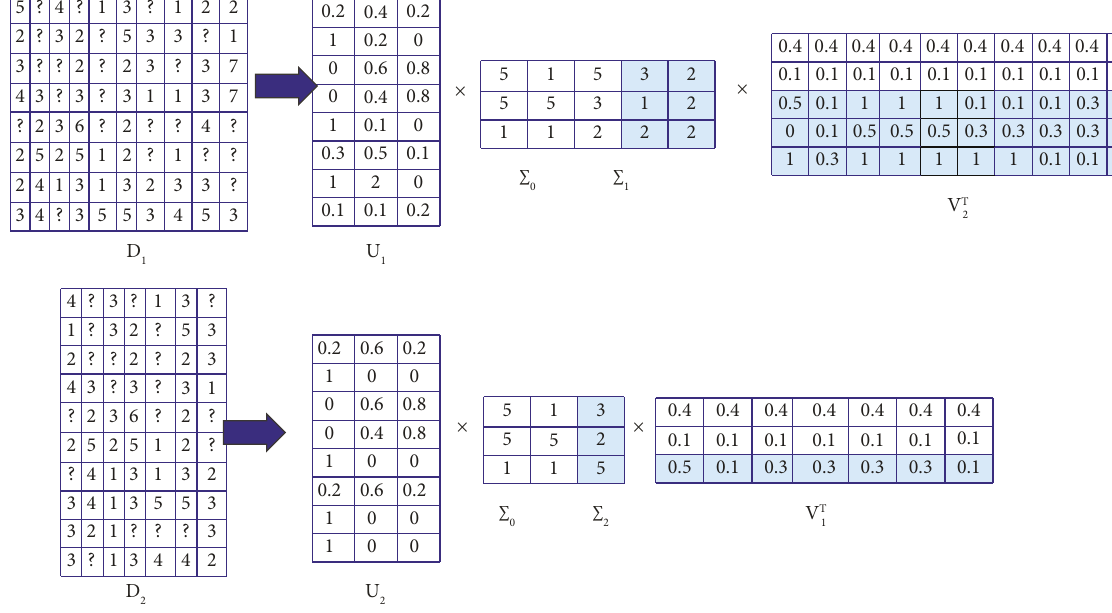
Figure 1: Illustration of the DSSCM